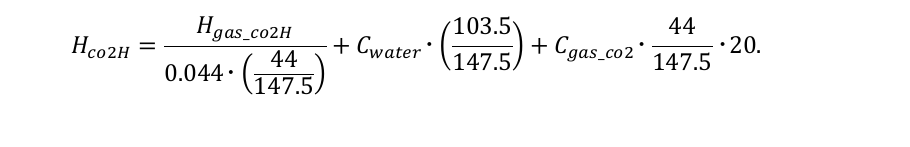
Table 6. Calculation condition of cold load